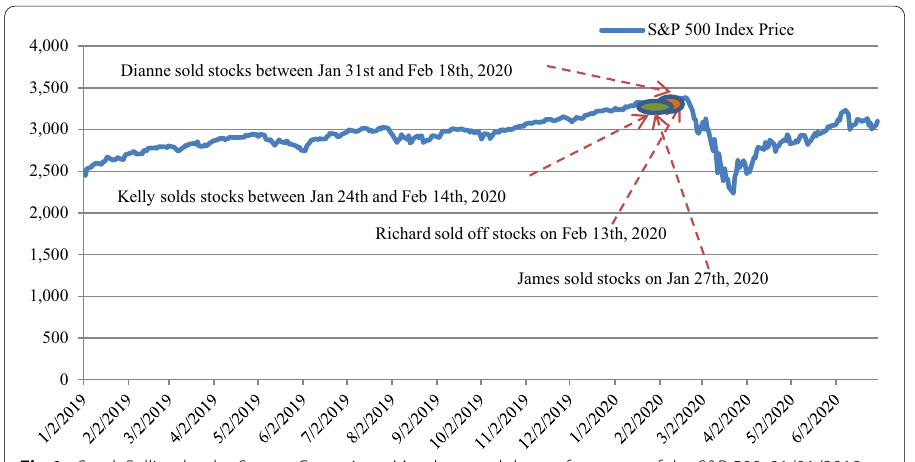
Fig 1. Stock Selling by the Senate Committee Members and the performance of the S&P 500: 01/01/2019– 06/30/2020. Notes : Figure 1 plots the timing of the stock selling by the senate committee members over